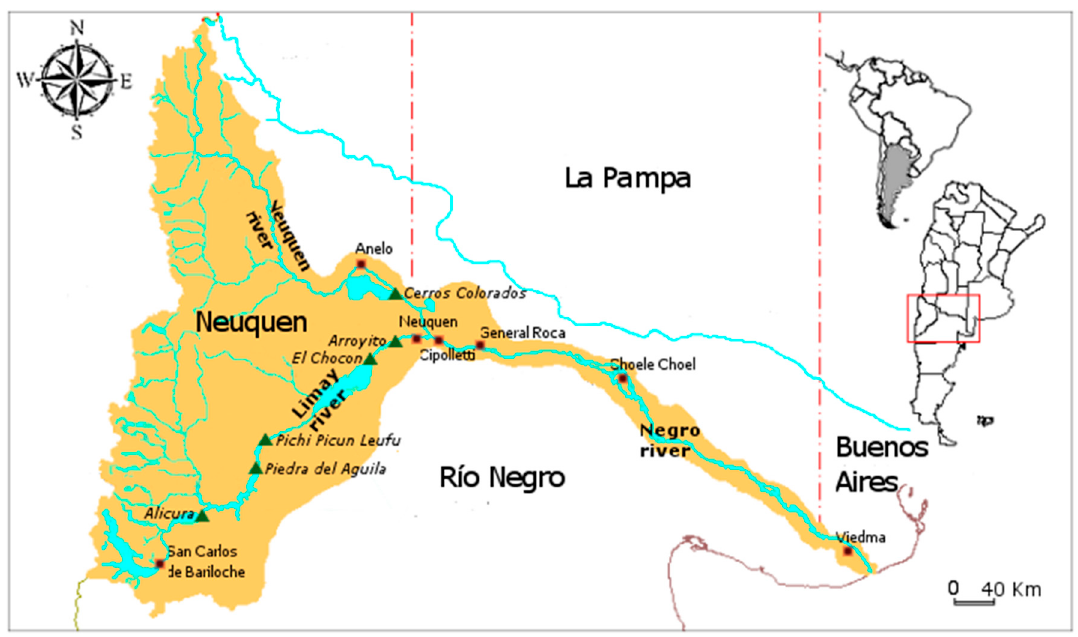
Figure 1. The Limay, Neuquén and Negro River basins.